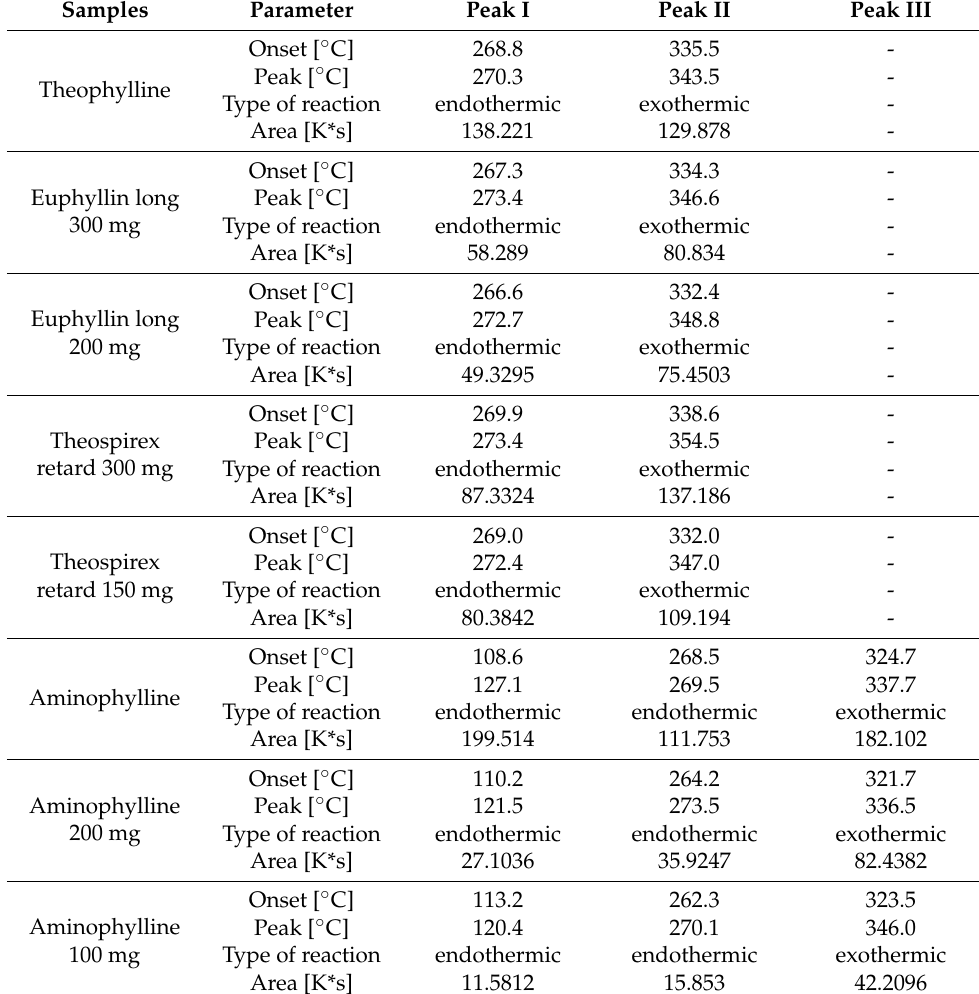
Table 3. Characteristic c-DTA parameters of the tested